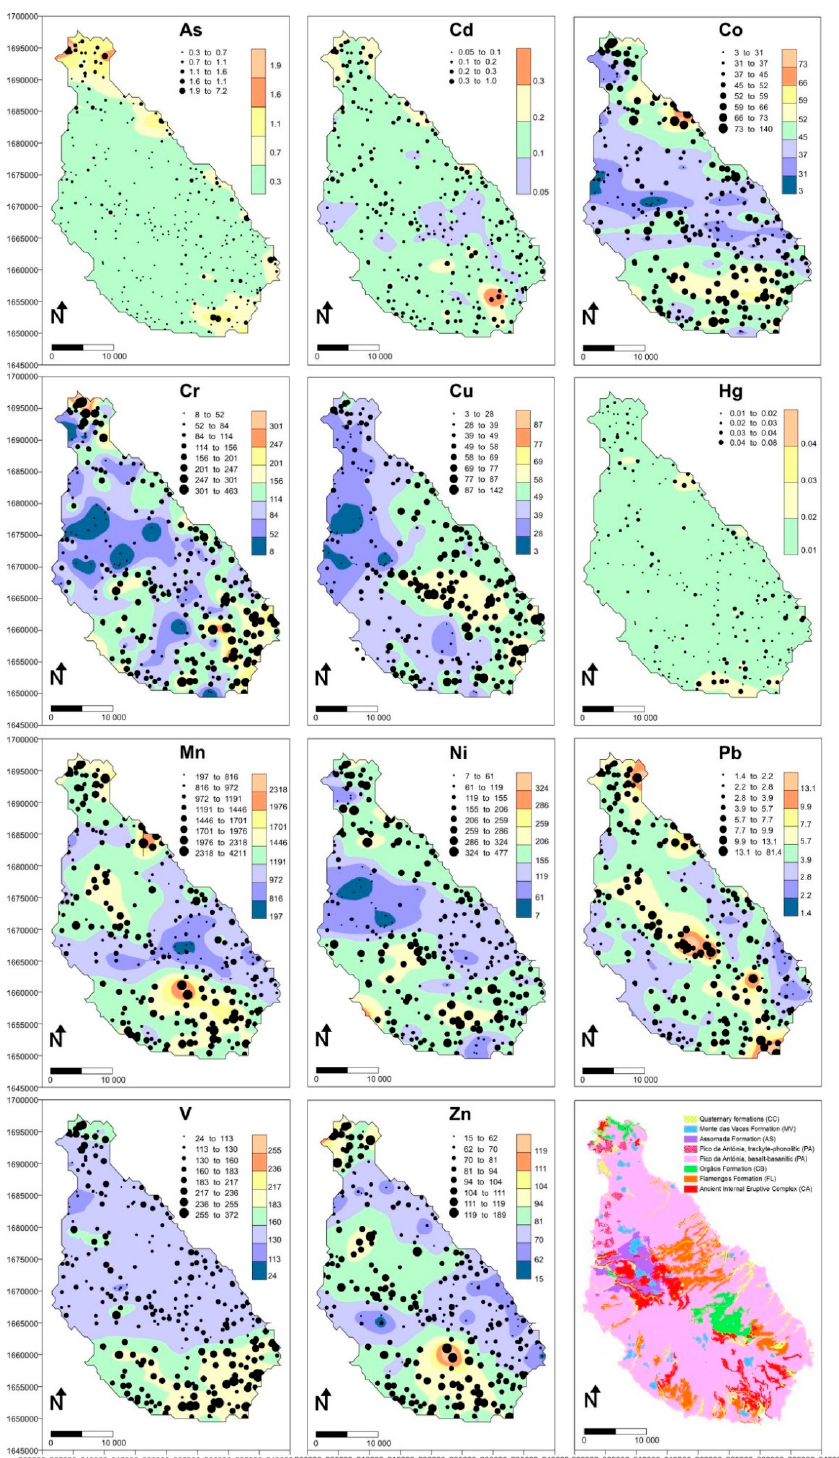
Figure 2. Spatial distribution of the As, Cd, Co, Cr, Cu, Hg, Mn, Ni, Pb, V and Zn baseline values. Coordinate system: UTM zone 27p. The geological map of Figure 1 is shown in the last panel for easier comparison with the BV spatial fields.